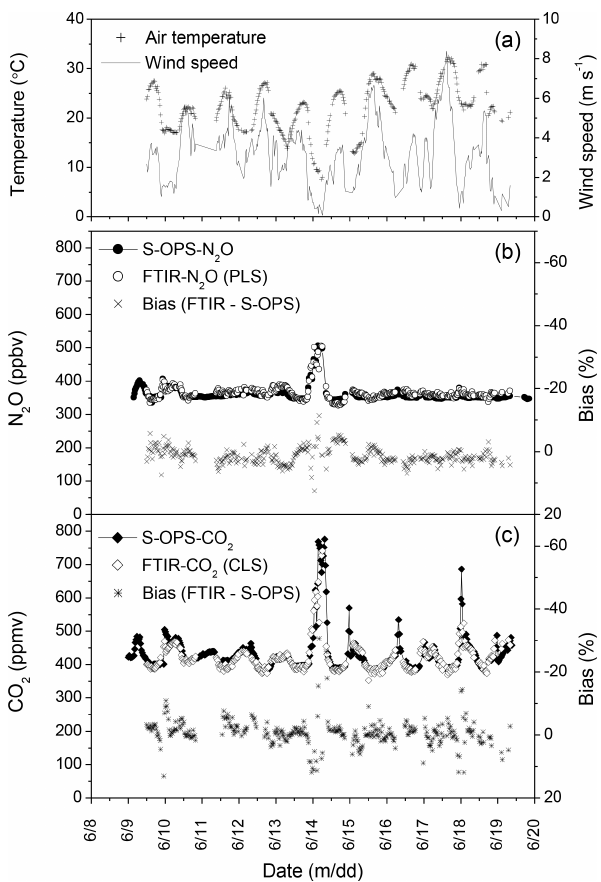
Figure 7. Measurements of air temperature, wind speed, N 2 O, and CO 2 concentrations from 9 to 19 June 2014. The 30min averages of (a) air temperature and wind speed; (b) N 2 O concentrations mea- sured from S-OPS using the DFG N 2 O analyser and calculated from OP-FTIR using the method of (syn-bkg + W N 3 + PLS), as well as the corresponding biases; and (c) CO 2 concentrations measured from S-OPS using LI-840 CO 2 analyser and calculated from OP- FTIR using the method of (syn-bkg + W C 2 + CLS), as well as the corresponding